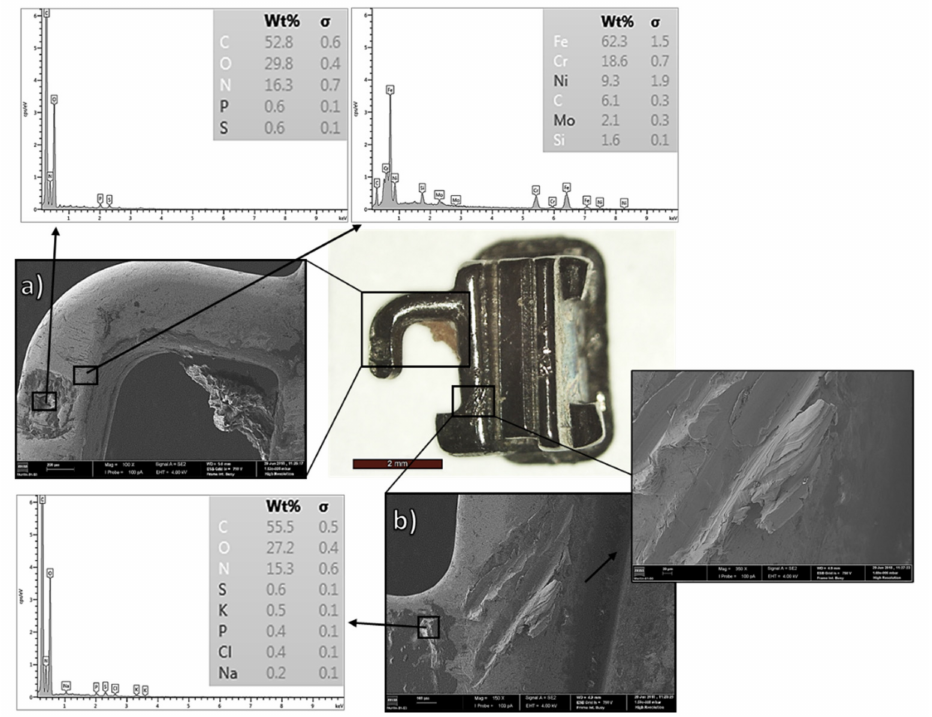
Figure 6. SS tube after two years of intraoral use: SEM and OM micrographs coupled with EDS chemical composition: ( a ) cavity filled with organic material; ( b ) wear track coupled with